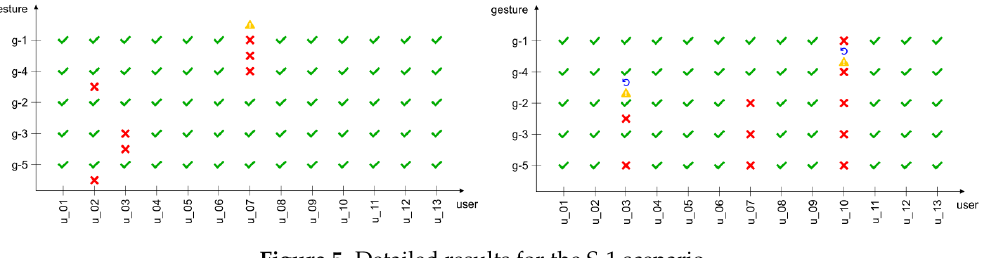
Figure 5. Detailed results for the S-1 scenario.